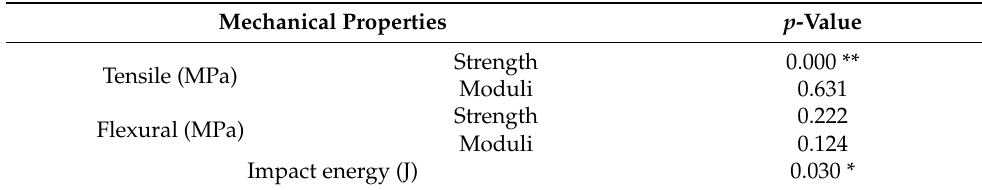
Table 4. Variance analysis of injection mold temperature effect on the mechanical properties ( p -values).